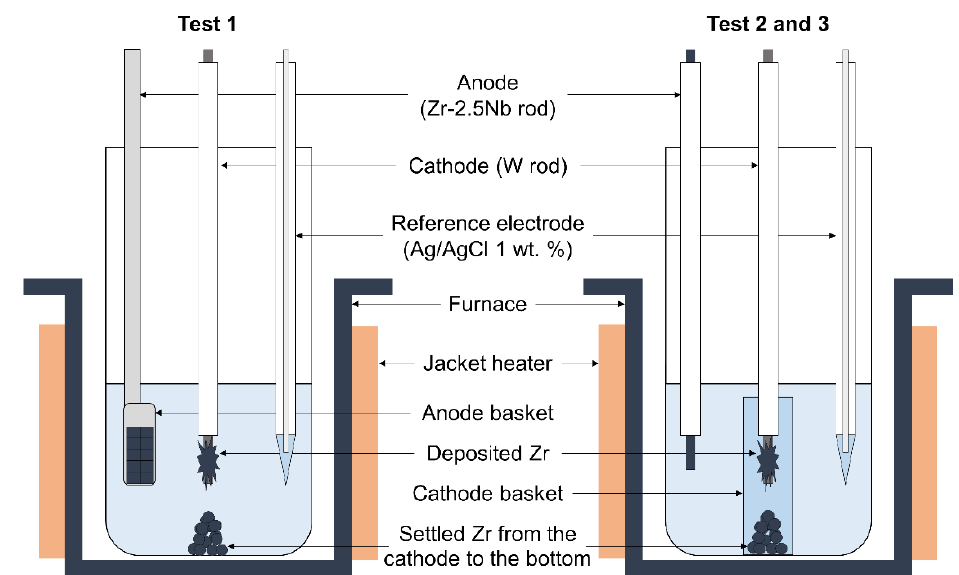
Figure 2. Schematic diagram of electrorefining cell utilized in tests 1 – 3.